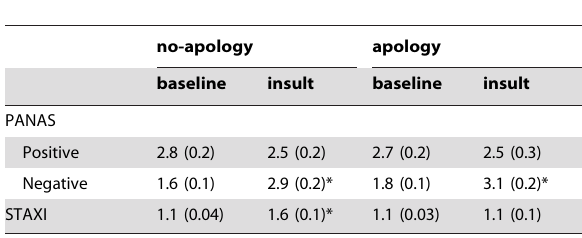
Table 1. Mean rating scores and standard error of subjective scales (PANAS and STAXI) for the no-apology group and the apology